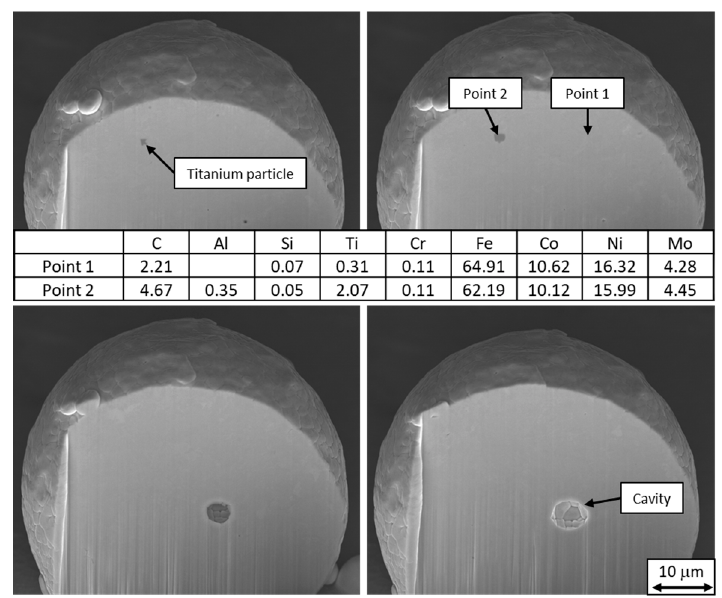
Figure 4. Micrographs of a progressively FIB-milled (from top left to bottom right) virgin powder particle containing a sharp-edged titanium inclusion and a cavity and chemical composition in weight percent measured by EDS. Different shapes of these defects were revealed in successive sections.